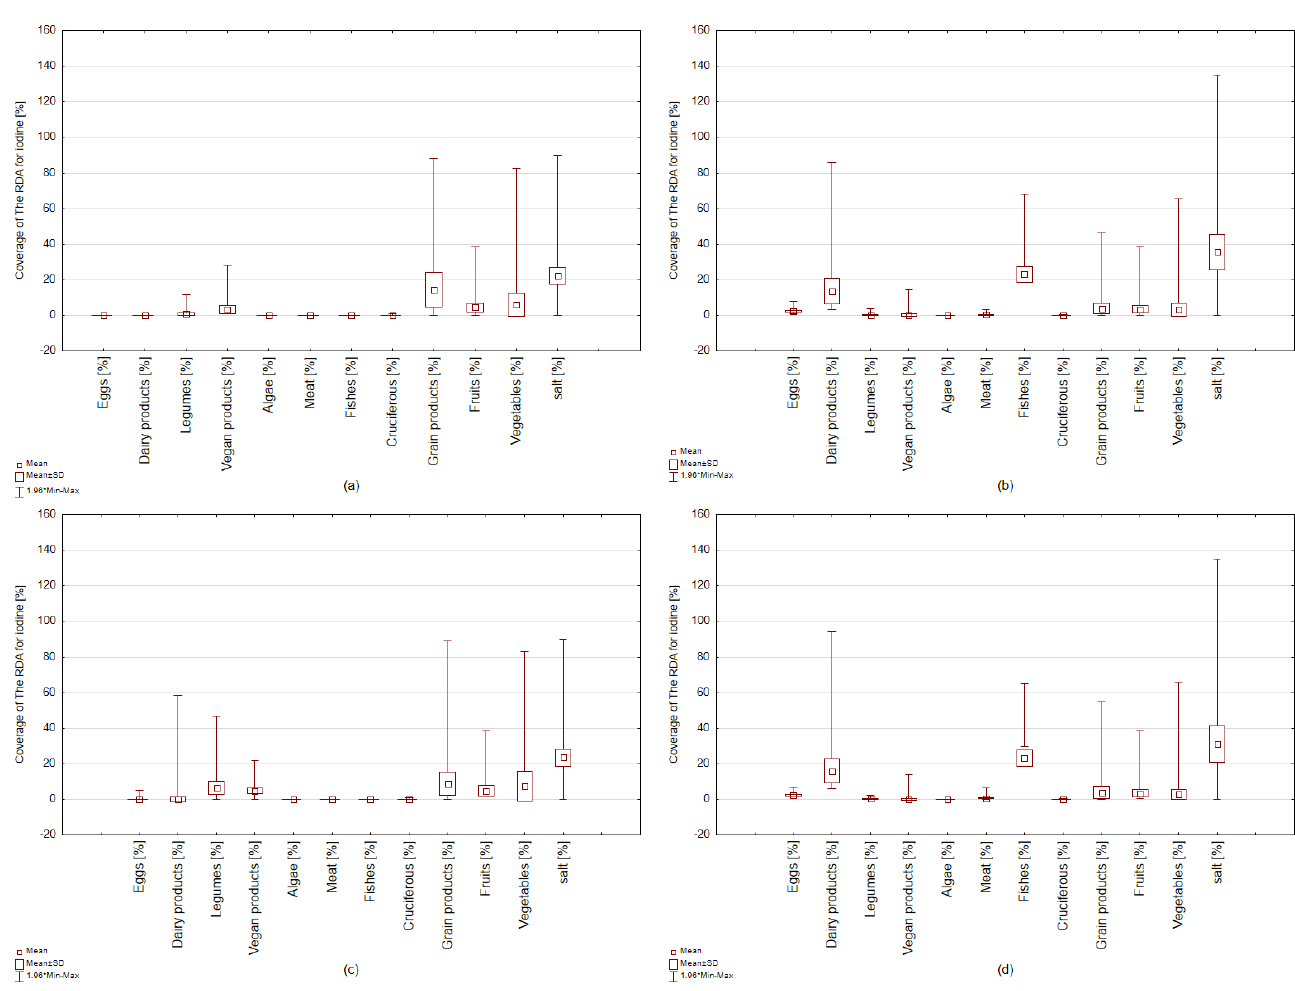
Figure 4. Contribution percentage of RDA for iodine from product groups among women with the vegan diet ( a ) and the omnivore diet ( b ) and men with the vegan diet ( c ) and the omnivore diet ( d ) aged 18 – 80 from Poland.